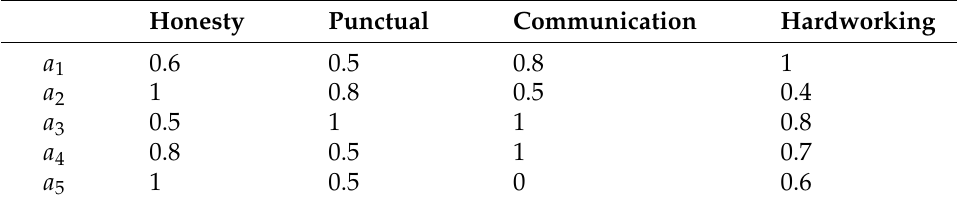
Table 1. Table of qualities in persons with their membership values.